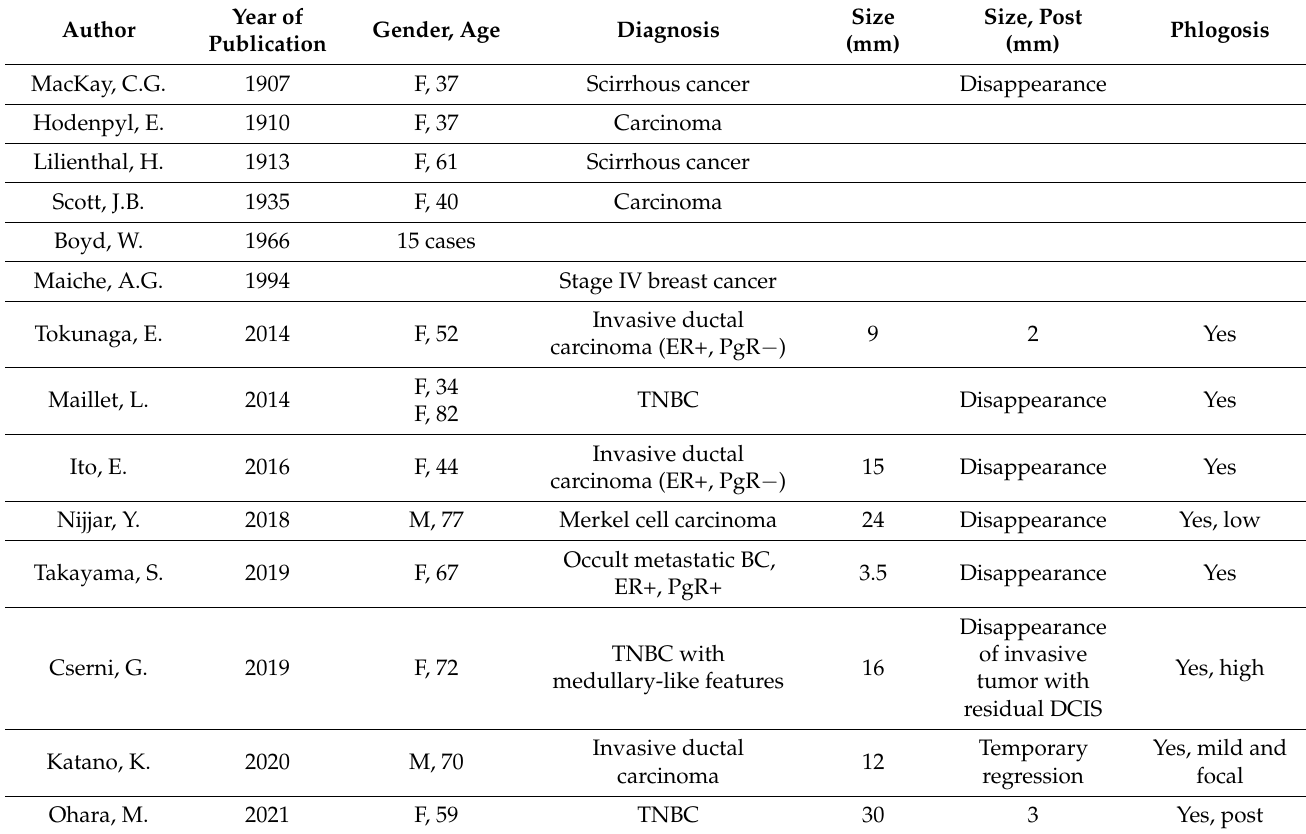
Table 1. Clinicopathological features of breast cancer–spontaneous